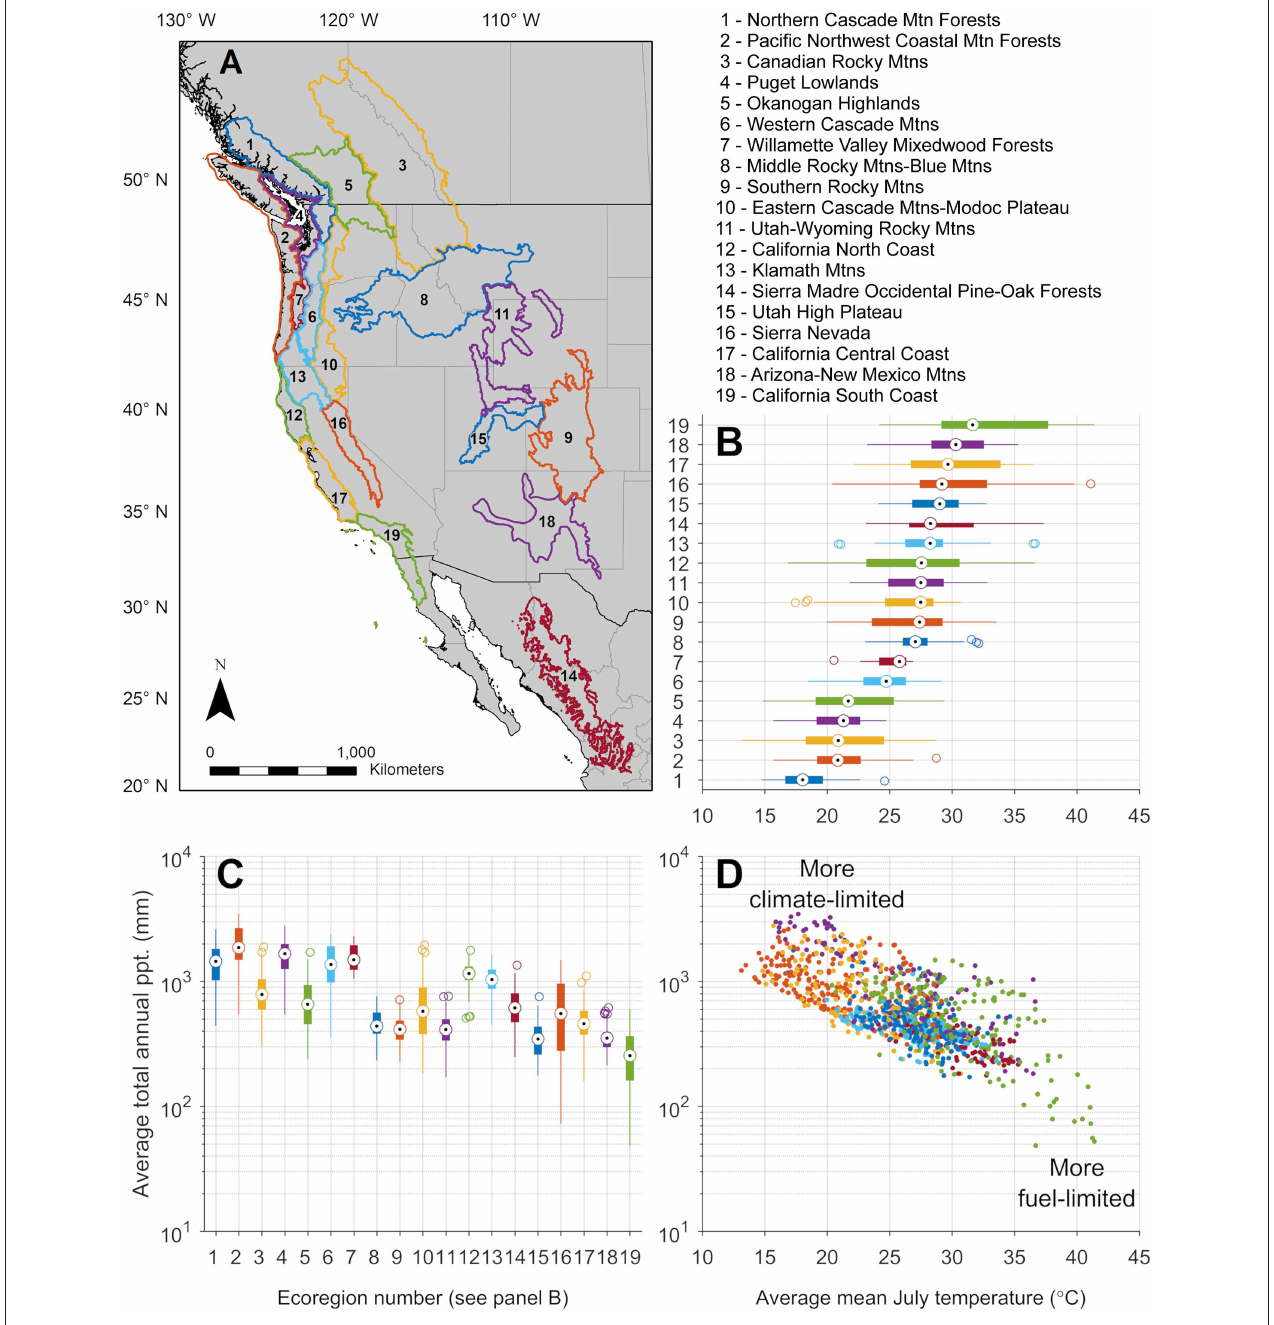
FIGURE 3 | Climatic ecoregions of western North America referenced in the text, in geographic (A) and climate space (B–D) . Ecoregions are organized in (B) by increasing average mean July temperature, from bottom to top; the same ordering is used in (C) for average total annual precipitation, from left to right. Globally, these two climate variables are the most relevant for predicting fire presence/absence (Krawchuk et al., 2009). Values in (B,C) define climate space (D) occupied by each 0.5 degree latitude grid cell, in each ecoregion. Ecoregions are based on Bailey (1998) but subdivided in The Nature Conservancy Terrestrial Ecoregions (Olson and Dinerstein, 2002). Climate data are from the Climate Research Unit (New et al., 1999), represent 1961–1990 average values, with a 0.5 ◦ spatial resolution.